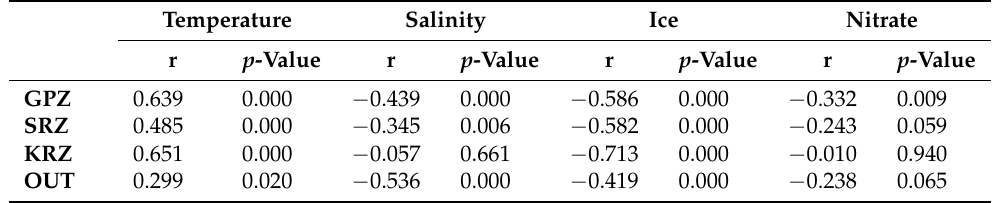
Table 3. Correlation coefficients of phytoplankton biomass (February) and other environmental variables (January) in different MPA regions and outside in